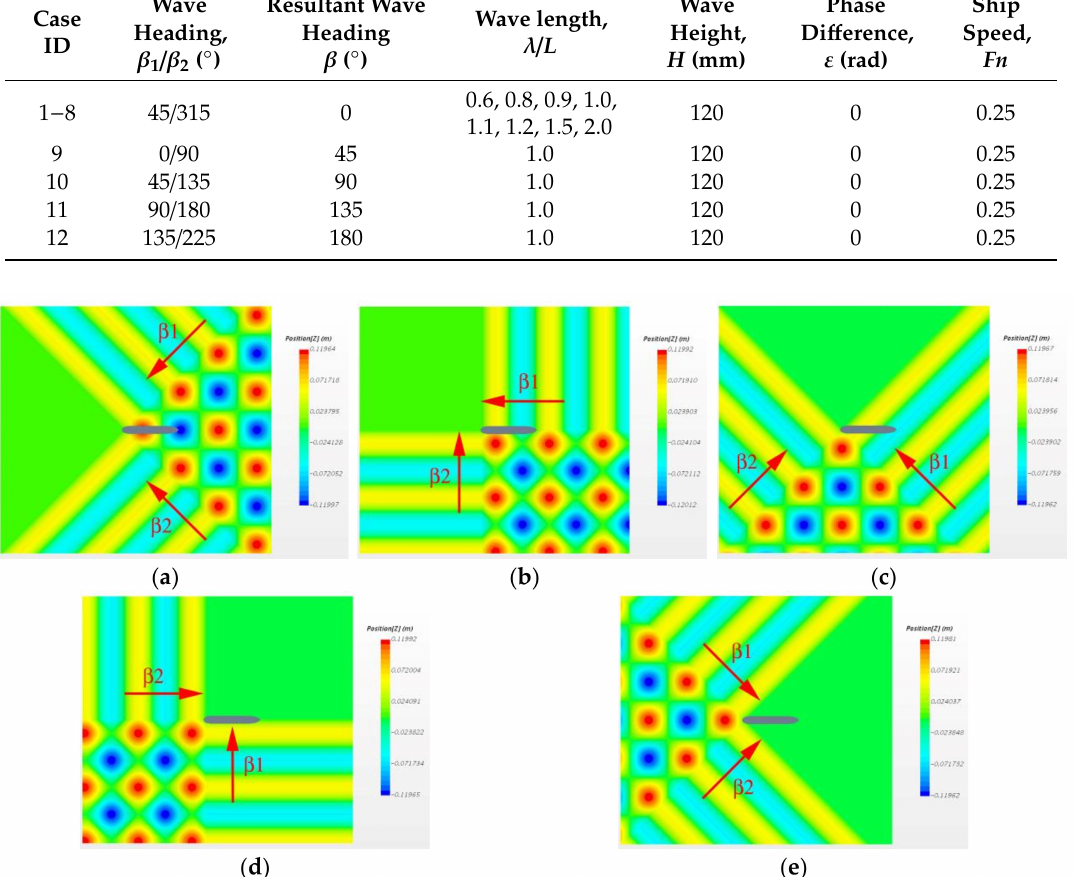
Figure 10. The initialized cross wave for di ff erent ship wave headings: ( a ) 45 ◦ / 315 ◦ (Case 4); ( b ) 0 ◦ / 90 ◦ (Case 9); ( c ) 45 ◦ / 135 ◦ (Case 10); ( d ) 90 ◦ / 180 ◦ (Case 11); ( e ) 135 ◦ / 225 ◦ (Case